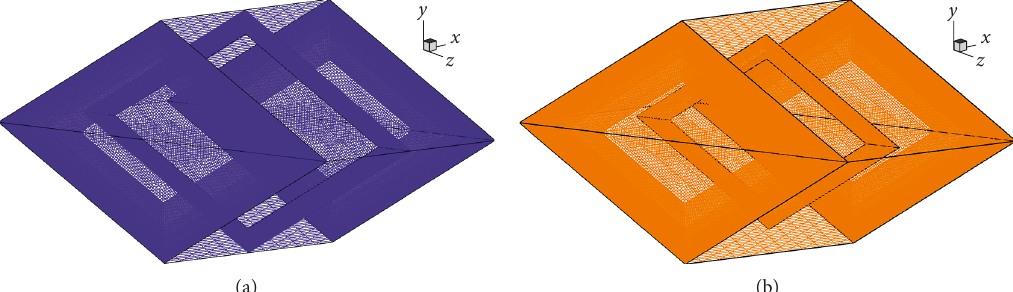
Figure 3: Computational domain with the mesh of the heat exchanger square duct installed with the 45 ° ISR for (a) b / H � 0.20, s / H � 0, and (b) b / H � s / H �